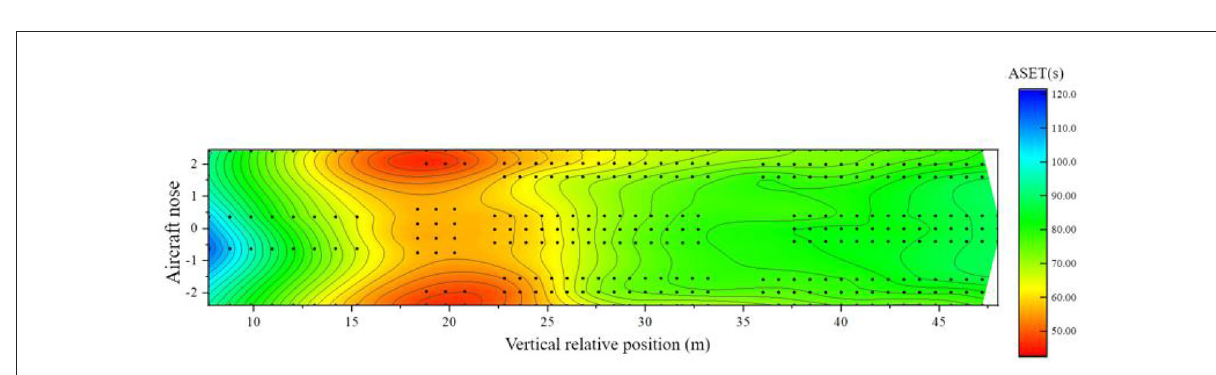
FIGURE10 Distribution of available evacuation time when the cabin is tilted